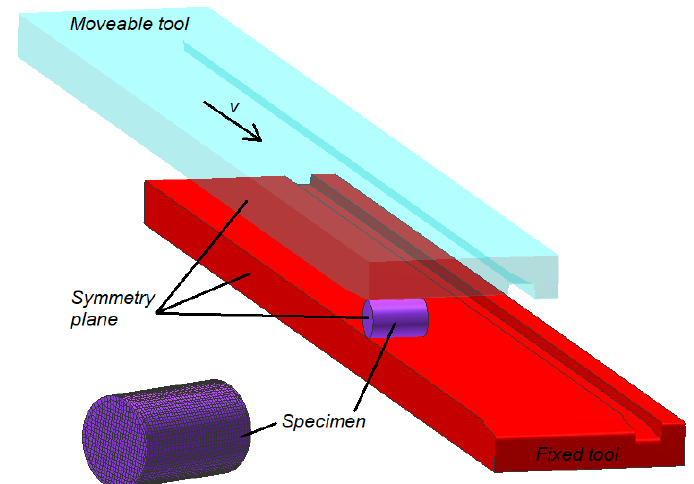
Figure 5. One of the geometrical models of the process of rotational compression used in the numerical analysis, in which the forming symmetry was applied.